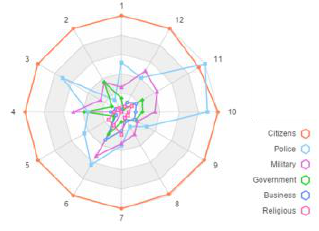
Figure 9 Active range of ISIS from 2007 to 2014